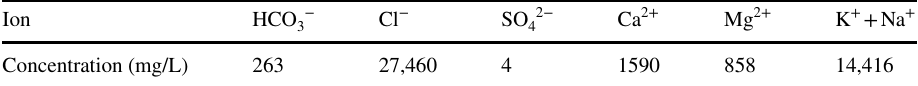
Table 1 Composition of the formation brine